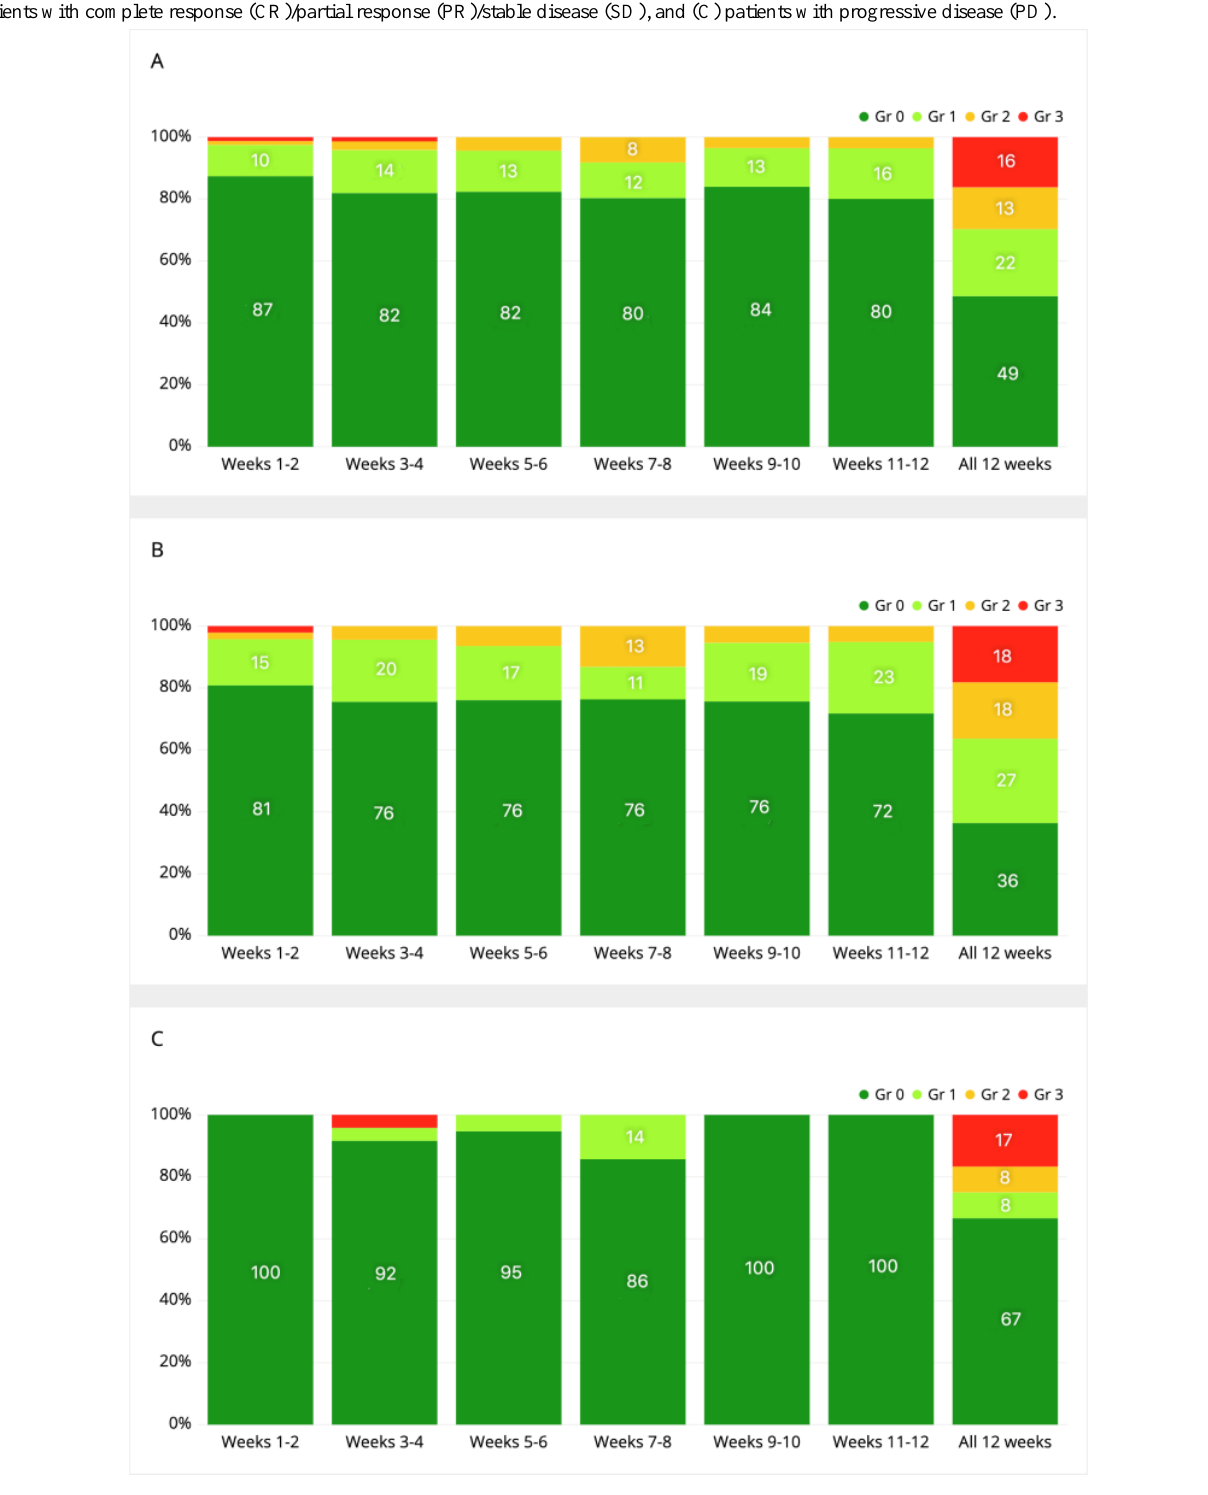
Figure 3. Distribution of the symptom grades reported on the symptom questionnaires during the first 12 weeks for itching for (A) all patients, (B) patients with complete response (CR)/partial response (PR)/stable disease (SD), and (C) patients with progressive disease